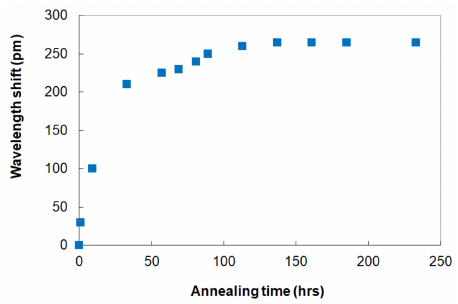
Figure 9. Bragg wavelength drift of π -shifted Type II FBG at 1000 ◦ C (reproduced from [55]. The same Ti-sapphire regenerative amplifier and phase mask were also used to in- scribe highly birefringent π -shifted FBGs in SMF-28 [56]. The birefringence (polarization- dependent Bragg wavelength; PD λ in Figure 10) was maximized when the linear polar- ization of the laser beam was aligned perpendicular to the fiber. The birefringence can grow to ~5 × 10 − 4 , which corresponds to a 500 pm polarization dependent drift of the π -phase-shifted passband feature. The birefringence can also be tuned using the ability to erase old nanostructures and simultaneously write new ones by changing the polarization of the femtosecond pulses. When exposed to 1000 ◦ C, the FBG birefringence drops to ~50% of its initial value at room temperature in the first 10–15 min, but then only slowly decreases in the next 100 h of annealing (Figure